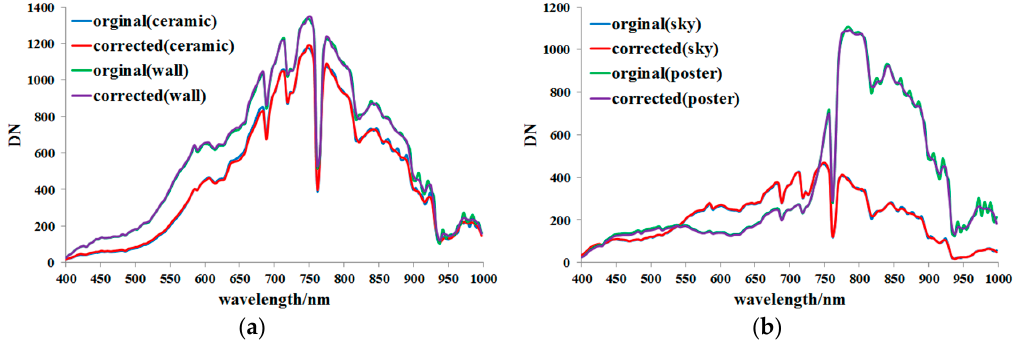
Figure 17. Comparison between the original spectra and the spectra corrected using the proposed method. ( a ) Ceramic and wall; ( b ) sky and poster.